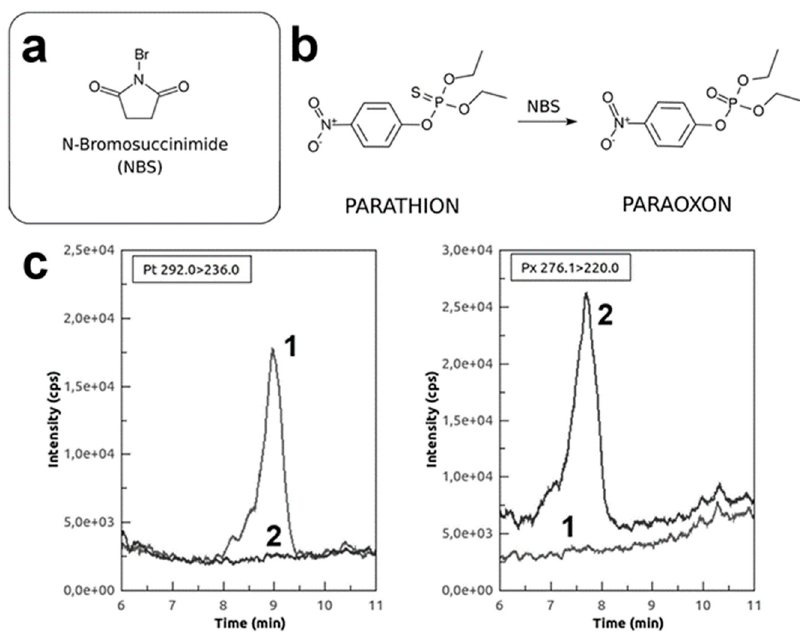
Figure 2. NBS-oxidized pesticides detection in water. ( a ) Chemical structures of N-bromosuccinimide and general formula of thio- and oxo-organophosphates. ( b ) NBS-mediated parathion/paraoxon transition. ( c ) LC-MS plot of transformation from parathion (baseline 1) to paraoxon (baseline 2), before (on the left) and after (on the right) the NBS oxidation step.